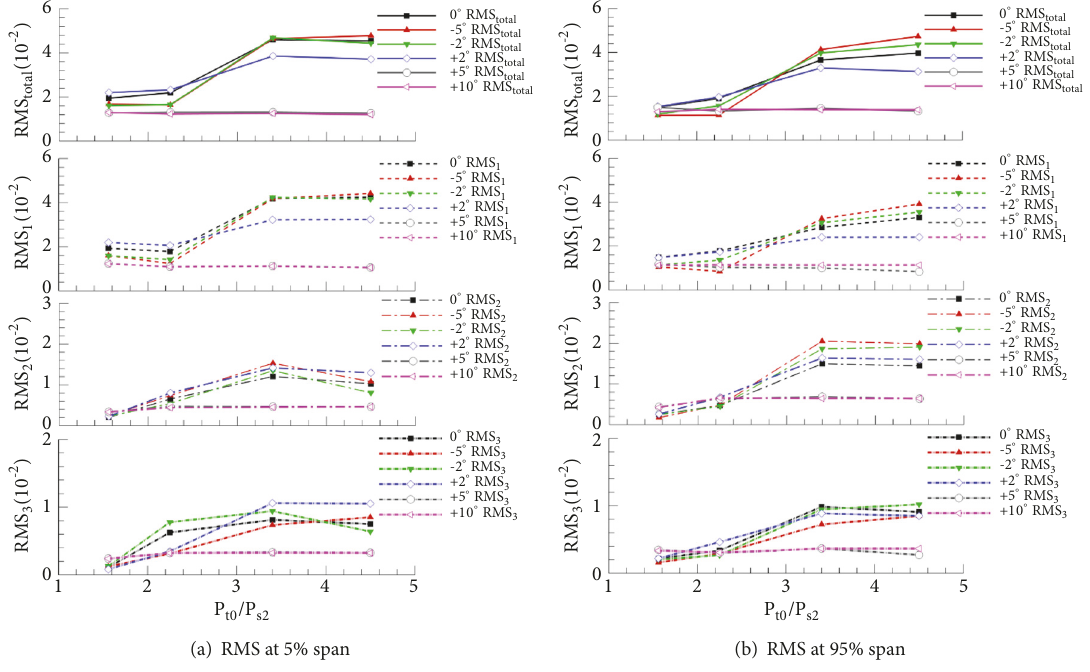
Figure 14: RMS of the pressure fluctuation at endwall